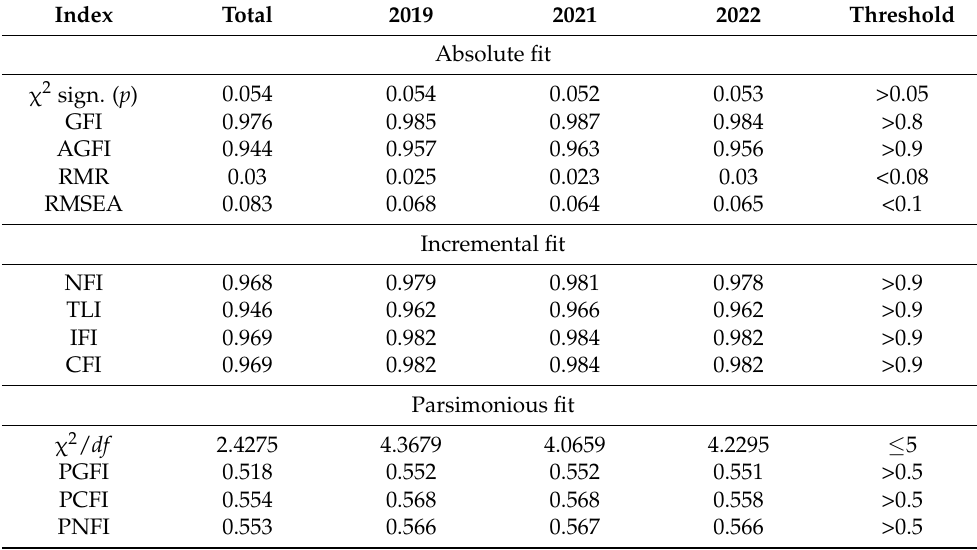
Table 1. Fit indices of the total model and the sub-models.